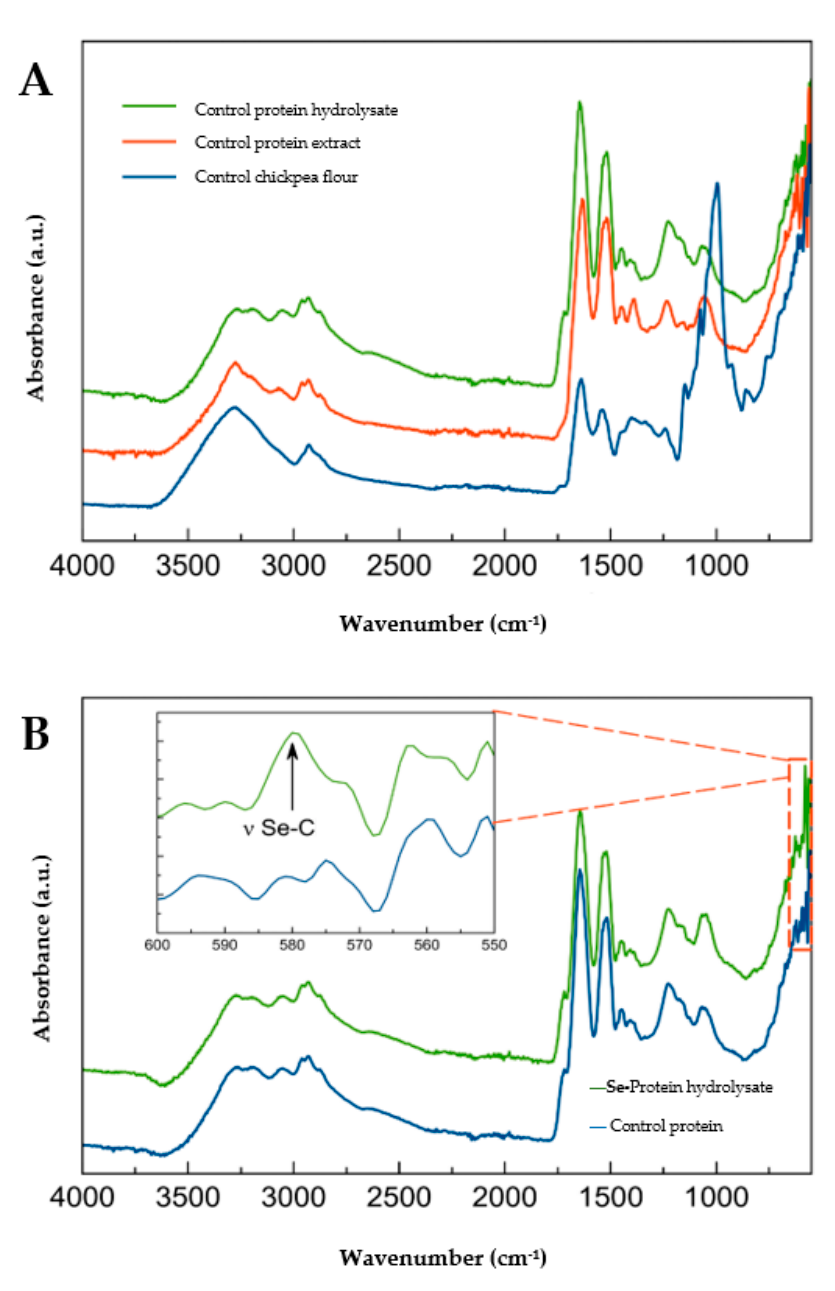
Figure 1. Fourier transform-infrared spectroscopy (FTIR) spectra of ( A ) Control protein hydrolysate with pepsin, protein extract, and germinated chickpea flour; ( B ) Selenized protein hydrolysate with pepsin and control protein